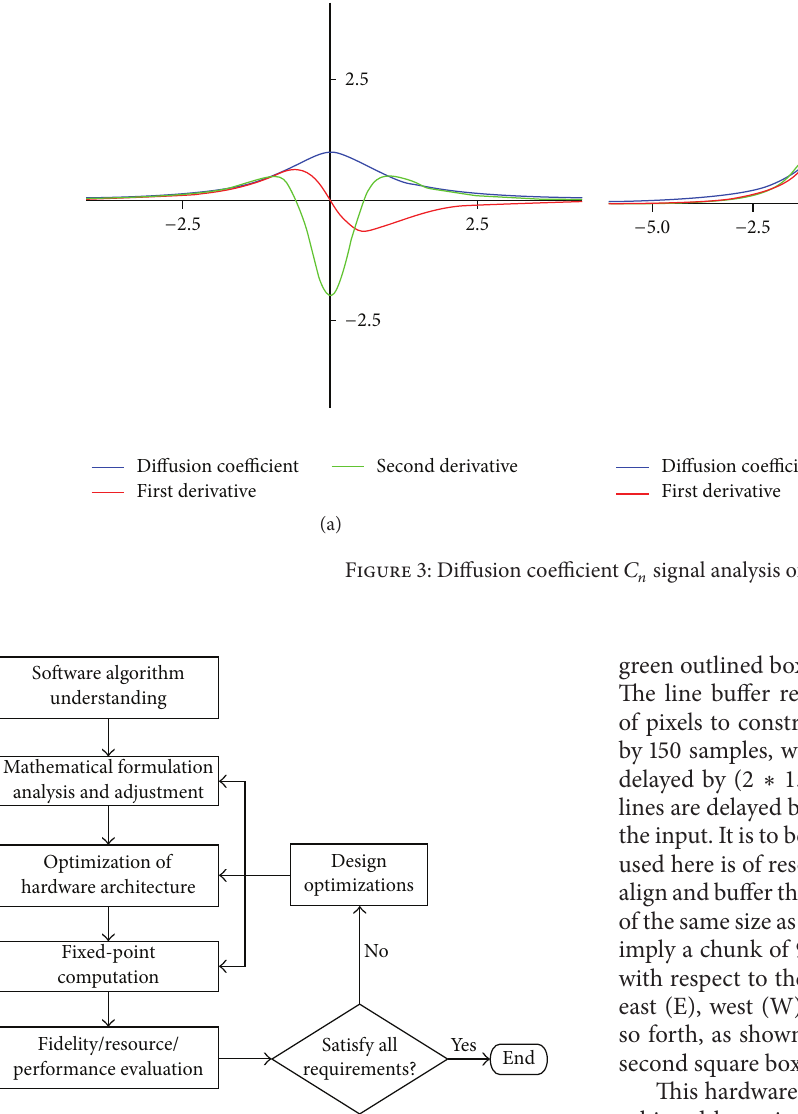
Figure 4: Algorithm to hardware design flow